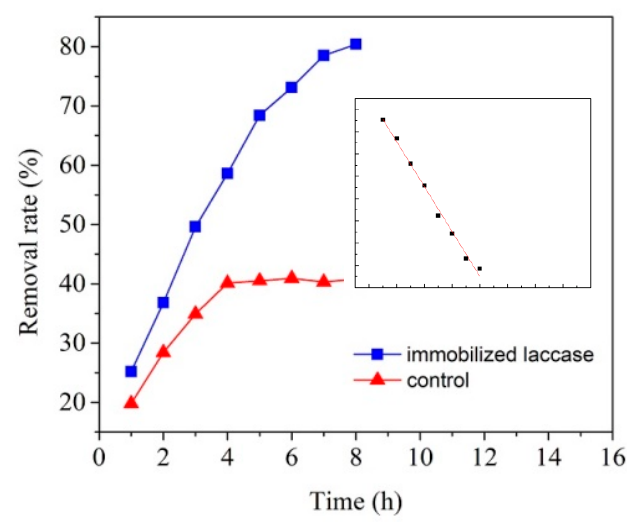
Figure 8. Removal rate of HO-DiCB by immobilized laccase and control (CCBs without laccase) at pH 4.0 room temperature; inlet: ln(1 − r ) vs. t plot of curve for immobilized laccase.